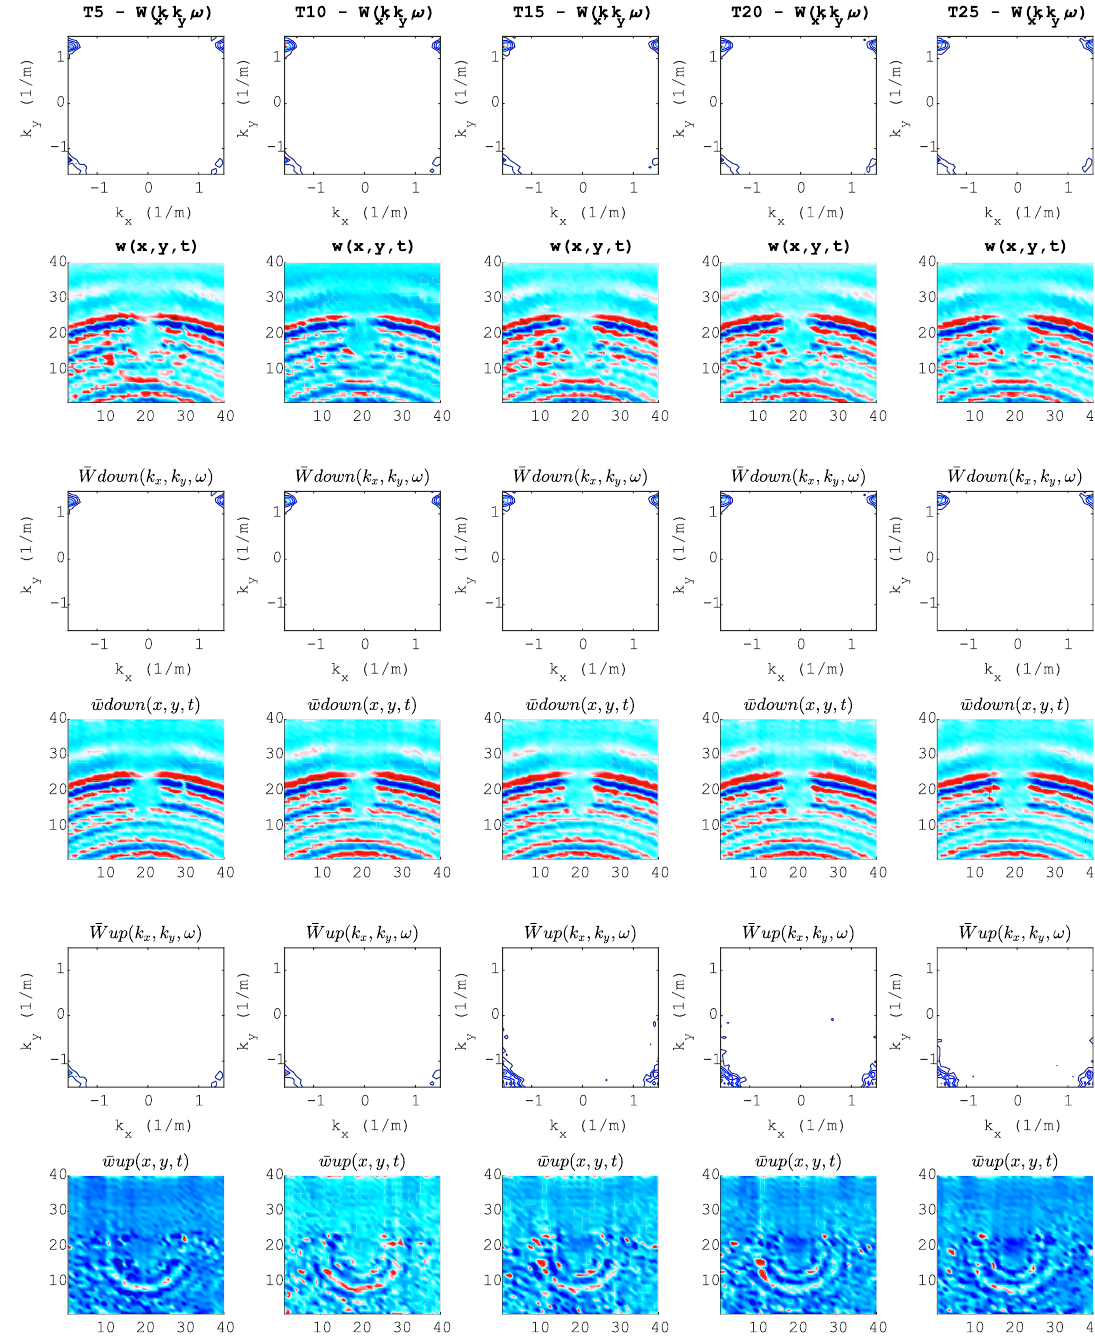
Figure 15. Preprocessing pipeline: Each column represents each torque value (T). Each row represents each processing step at t = 37 µ s. Row 1: 3D FT before filtering; Row 2, full wavefield before filtering; Row 3, 3D FT after filtering down-propagation waves; Row 4, full wavefield after filtering down-propagation waves; Row 5, 3D FT after filtering up-propagation waves; Row 6, full wavefield after filtering up-propagation